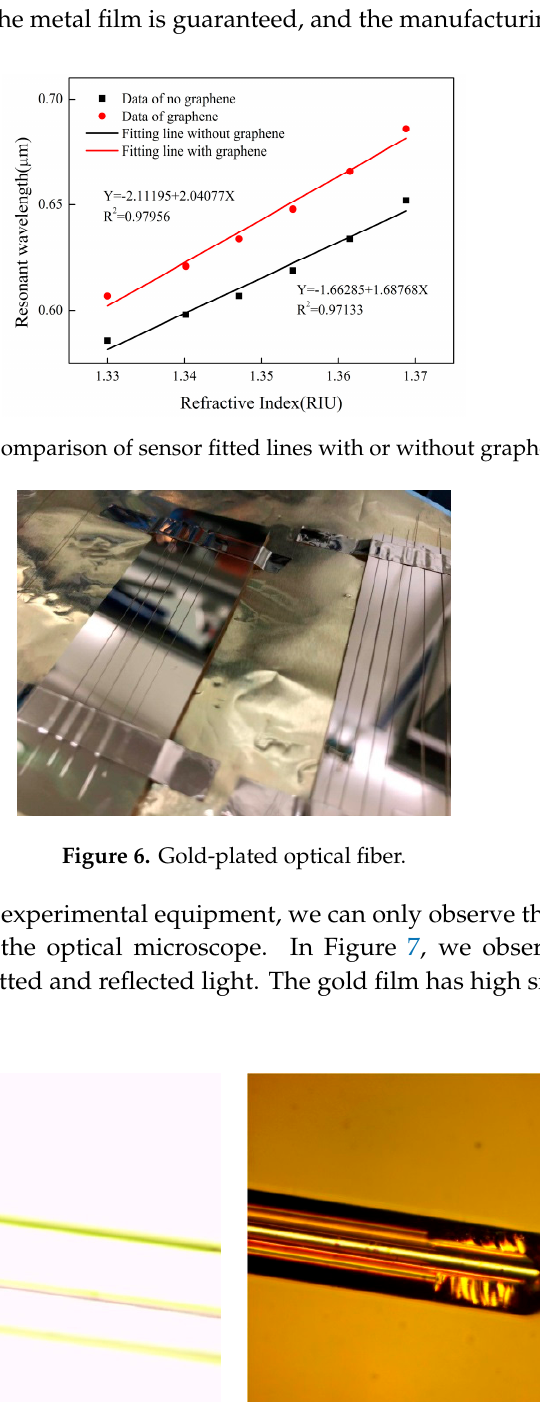
Figure 5. Comparison of sensor fitted lines with or without graphene.